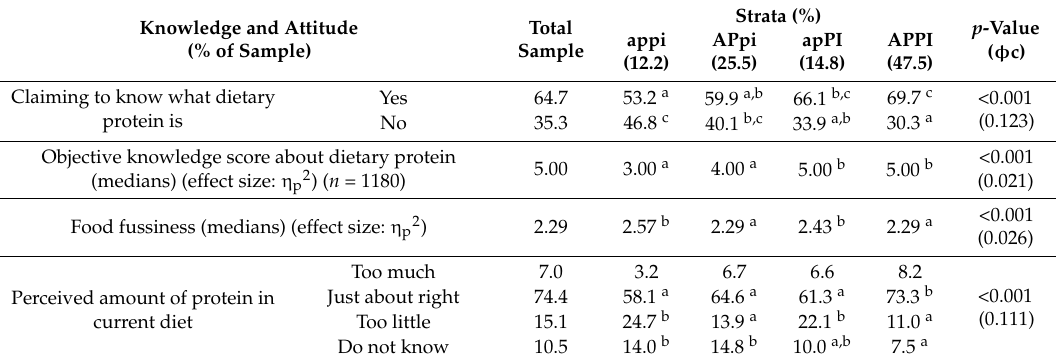
Table 5. Strata profiles based on knowledge of and attitude towards protein, food and diet in 1825 adults aged 65 years and older from five European